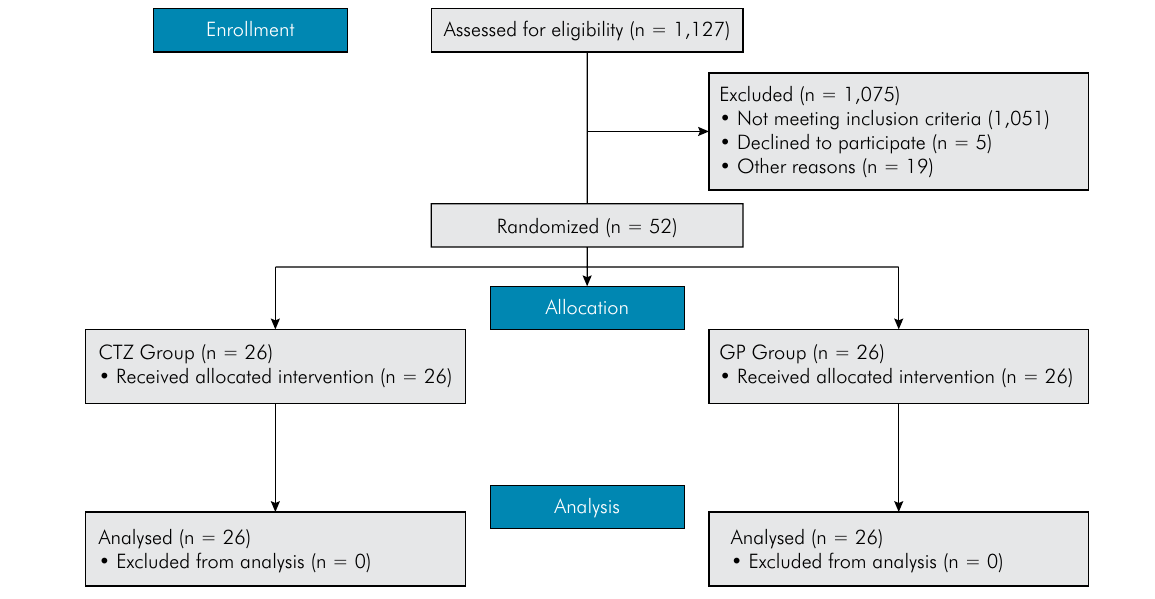
Figure 1. Flow chart of the study design.